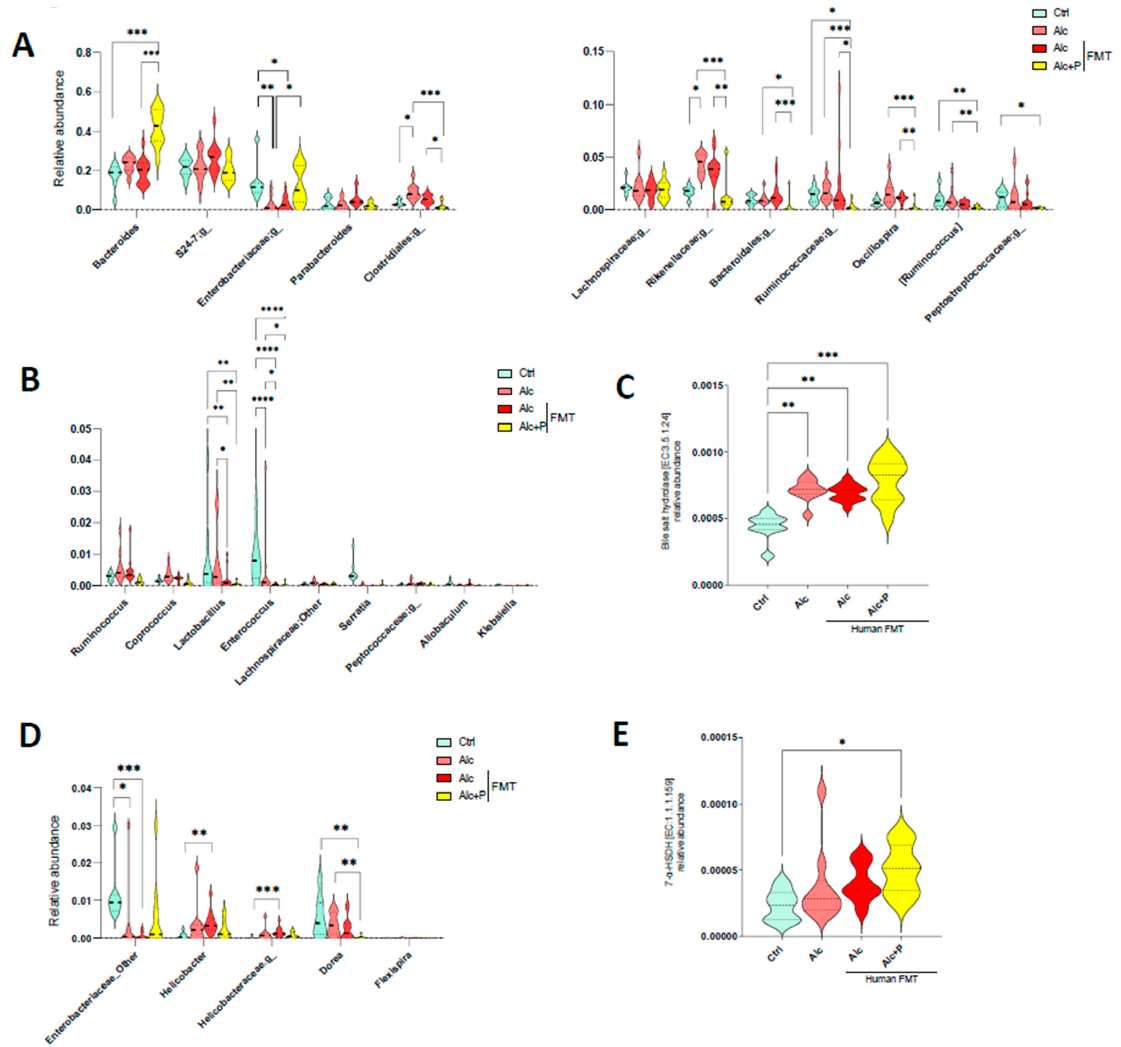
Figure 4. Alterations in the composition of bile acid-metabolizing bacteria in alcohol fed-mice. Con- trol (Ctrl) and alcohol-fed (Alc) mice received a Lieber DeCarli diet with isocaloric maltodextrin or alcohol, respectively. Pectin-treated mice (Alc + p ) received 6.5% pectin in addition to 5% ethanol. Human fecal microbiota transfer (FMT) groups received fecal microbial transplantations from a pa- tient with alcoholic hepatitis. ( A , B , D ) Violin plots showing the relative abundance of bacteria with bile salt hydrolase ( A , B ) and 7 alpha-hydroxysteroid dehydrogenase (7-a-HSDH) activity ( D ) in all groups of mice (FDR p < 0.05). Predictive expression of bile salt hydrolase ( C ) and 7-a-HSDH ( E ). * p < 0.05, ** p <0.01, *** p < 0.001, **** p < 0.0001. 3.3. Pectin Modifies Bile-Acid Signaling in the Gut, Liver, and Brown Adipose Tissue BA levels depend not only on their excretion by the liver but also on intestinal reab-